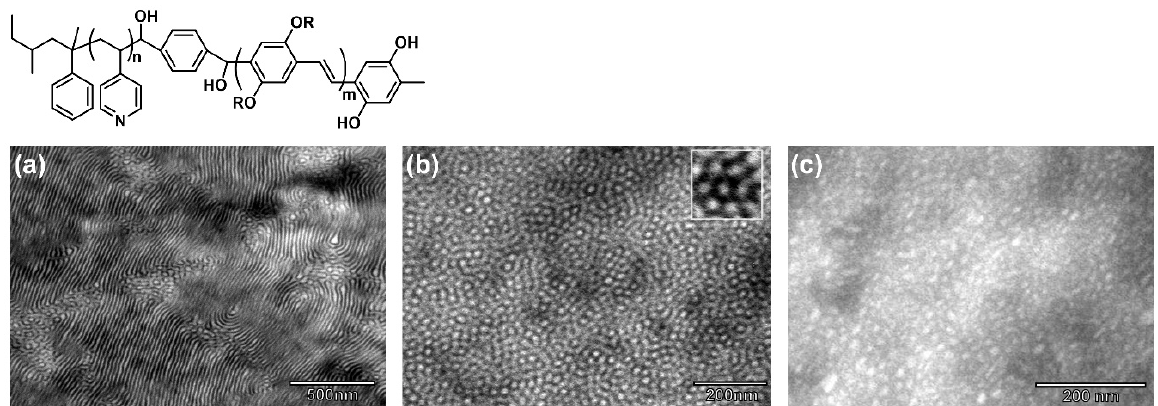
Figure 11. Iodine-stained TEM micrographs of ( a ) PPV 11 - b -P4VP 51 (ordered lamellar structure); ( b ) PPV 11 - b -P4VP 173 (ordered hexagonal phase); ( c ) PPV 11 - b -P4VP 295 (poor order of spherical phase). (Reprinted with permission from Ref. [92]. Copyright American Chemical Society).